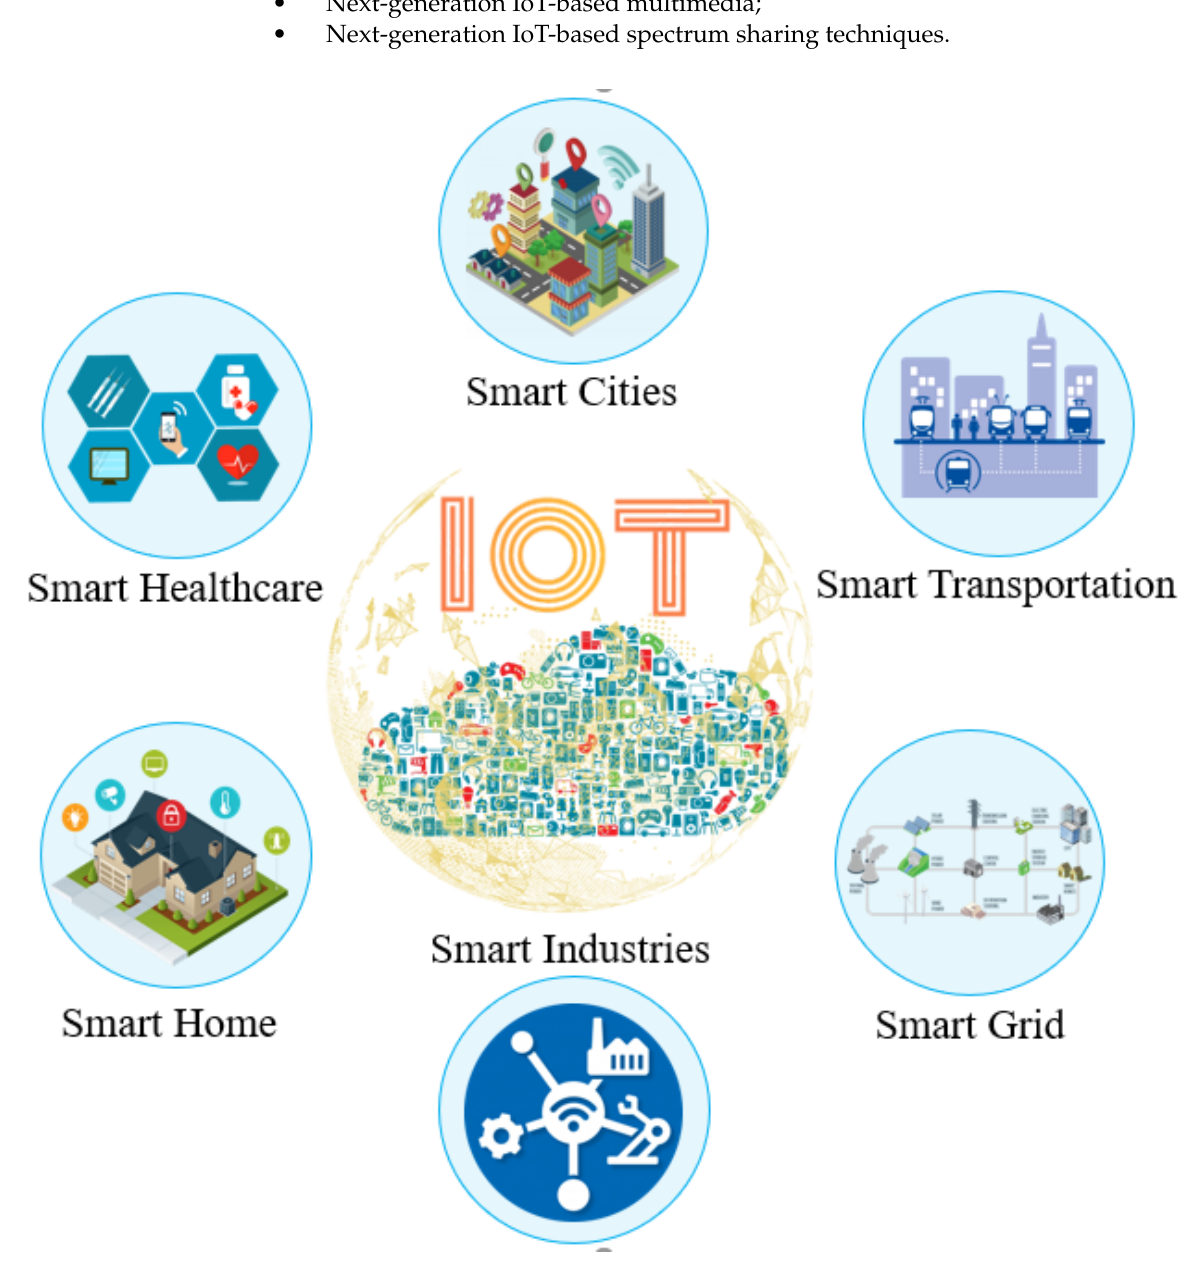
Figure 1. Next-generation Internet of Things (IoT)-based